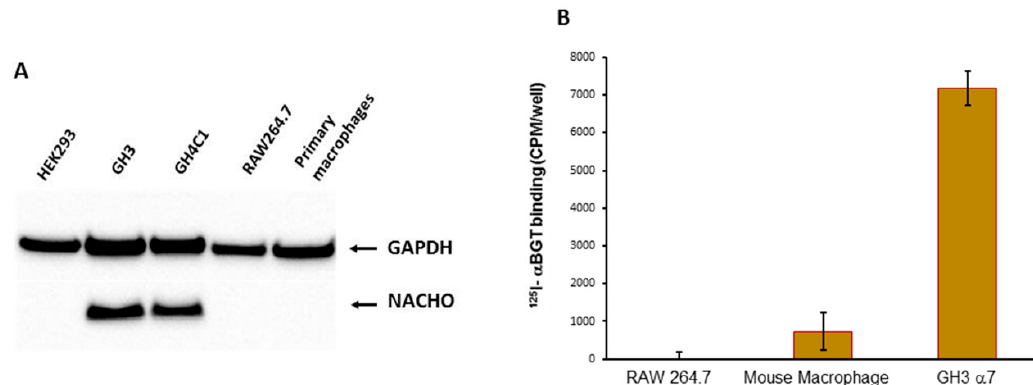
Figure 1. ( A ). Western Blot analysis of NACHO expression. GH3 and GH4C1 cells express endogenous NACHO, but mouse macrophage-like RAW264.7 cells, primary mouse macrophages, and HEK-293 do not. ( B ) In vitro 125 I- α BGT binding assessments. Primary cultured macrophages and GH3 cells transfected with rat chrna7 plasmid, but not RAW264.7 mouse macrophage-derived cells, showed 125 I- α BGT binding.